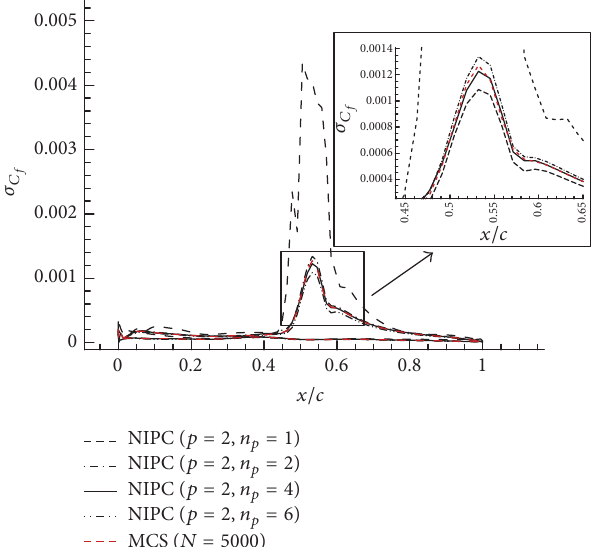
Figure 9: Standard deviation distribution of 𝐶 𝑓 with oversampling ratio 𝑛 𝑝 .